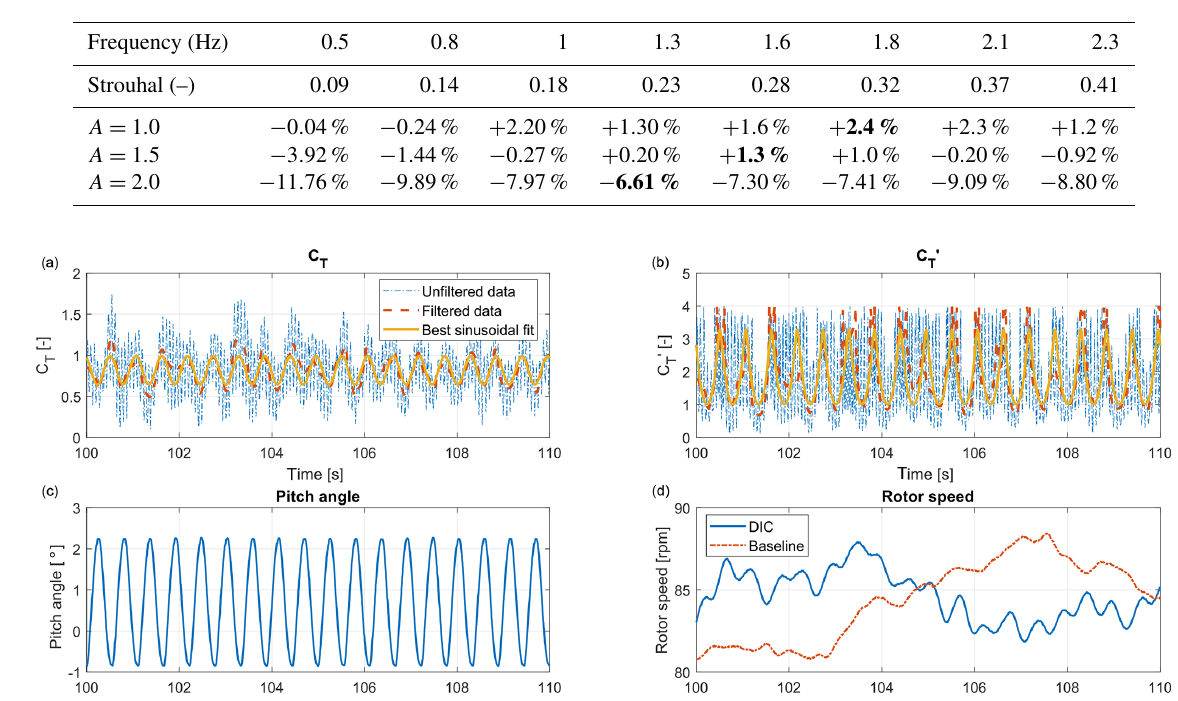
, rotor speed and pitch angles of turbine 1 are shown during 10s of the optimal St = 0 . 32, A = 1 Figure 11. Clockwise, the measured C T , C (cid:48) T DIC experiments in low TI. In ( a ) and ( b ), the unfiltered data, low-pass filtered data and a best sinusoidal fit are shown. In ( d ), the rotor speed during 10s of the baseline experiment is shown for comparison.